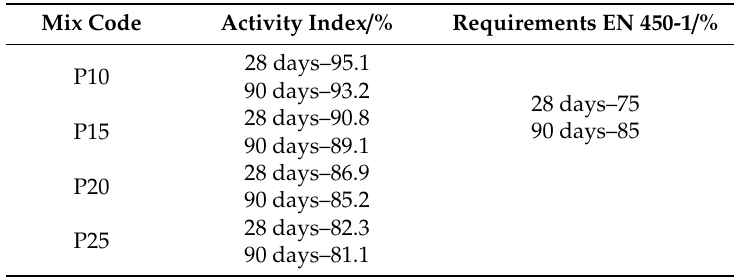
Table 11. Activity indexes of mixtures with di ff erent amounts of silica fume.